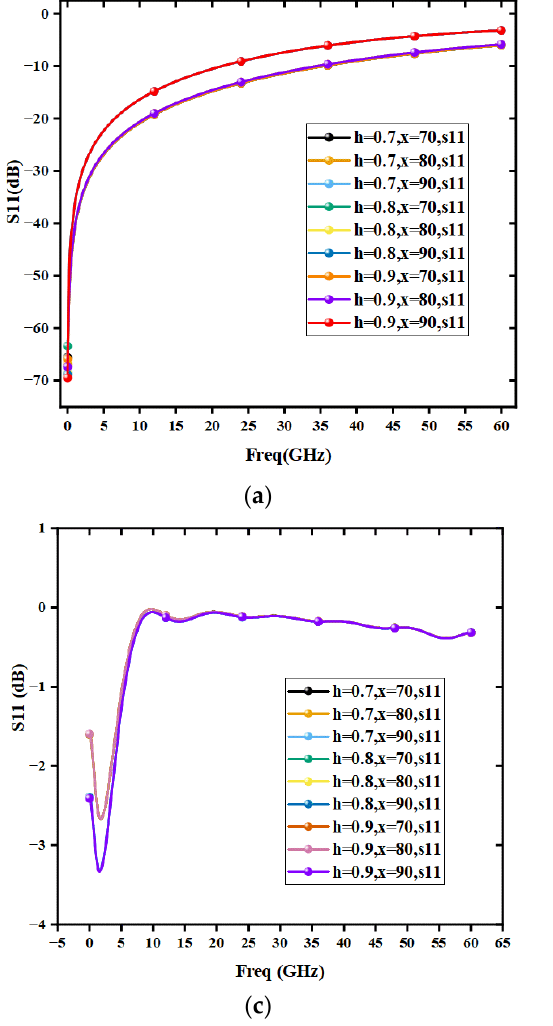
Figure 12. Variation of the position and height of the support pillars on the electromagnetic perfor- mance of the MEMS switch, ( a ) MEMS open-state S11, ( b ) MEMS open-state S21, ( c ) MEMS off-State S11, ( d ) MEMS off-state S21.